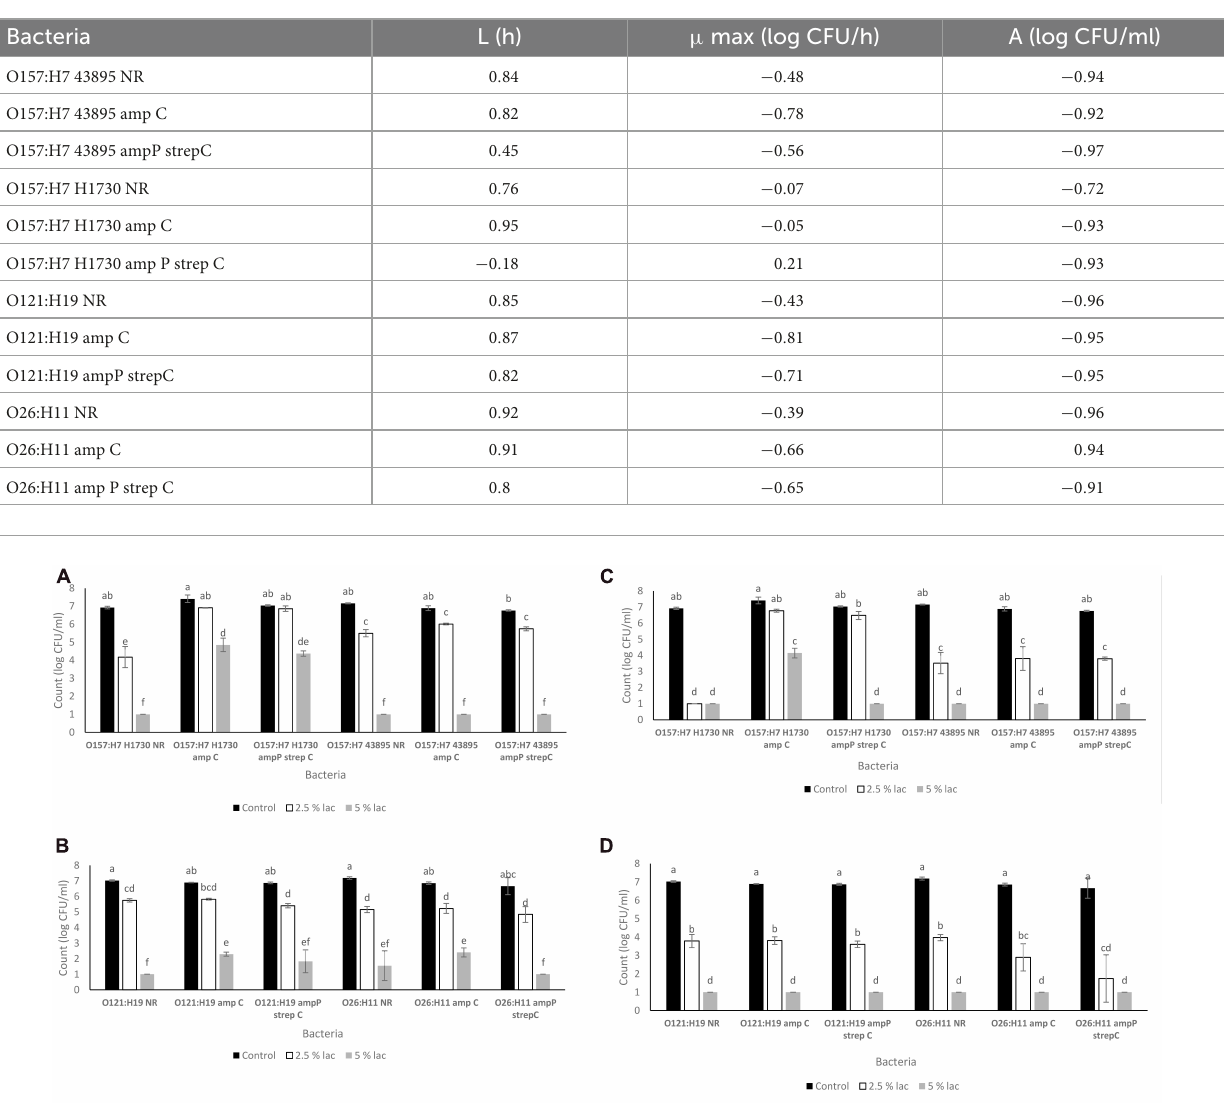
TABLE 3 Correlation between lactic acid concentration and growth parameters of STEC.